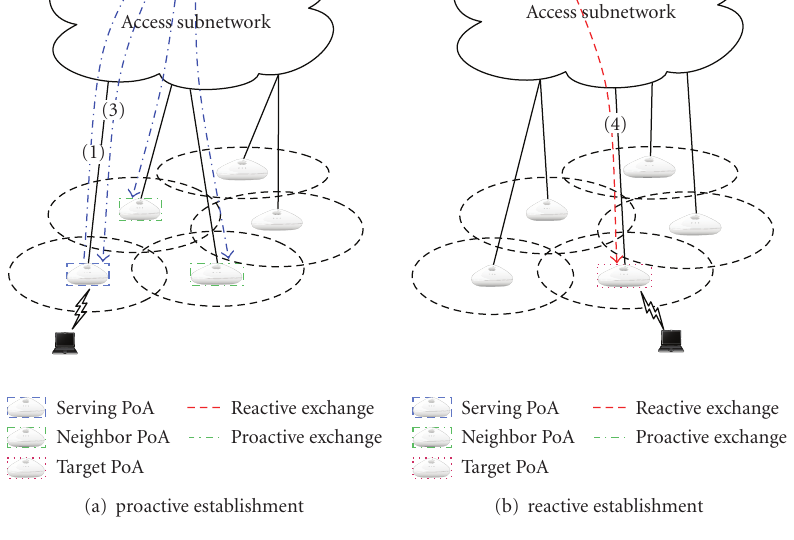
Figure 2: Centralized establishment.